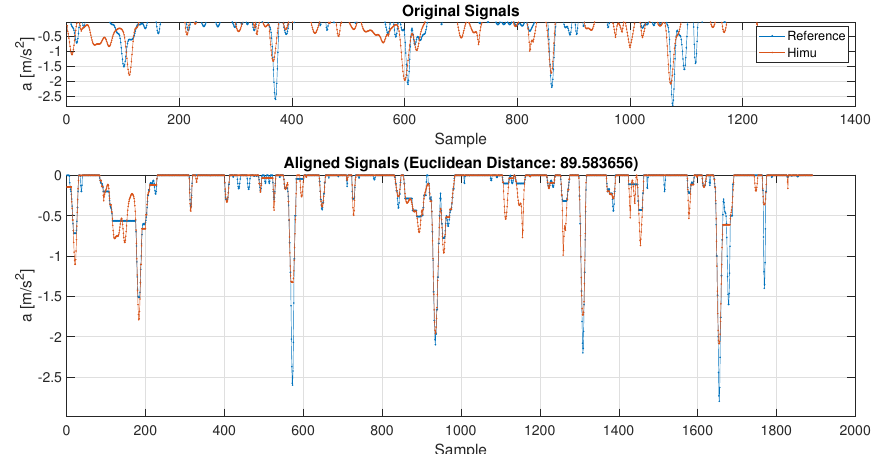
Figure 10. C1—DTW between reference and HIMU acceleration signals. Once the sensor acceleration signals are opportunely preprocessed (denoised, outlier removed, filtered and resampled), it is now possible to find the best configuration of the filtering parameters ( ω c ; n ) that minimize the Euclidean distance, evaluated with the DTW procedure, among the reference acceleration, a ref , and those ones detected by VBOX, GPS1 and HIMU sensors, respectively a VBOX , a GPS 1 and a HIMU . In particular, the interval of the cut off frequency ω c has been set between 0.1 Hz to 2 Hz with an increasing step equal to 0.05, whereas the filter order changes between 1 and 8 with an increasing step equal to 1. In the case of VBOX, Figure 11, the best configuration is achieved with an order equal to n = 7 and a cut-off frequency equal to ω c = 1.05 Hz. These parameters allow to reach = 74.8749. As it is possible to see in Figure 11b, a minimum distance equal to d a ref ; a VBOX the VBOX acceleration follows almost faithfully the reference signal: obviously the VBOX signal considers all the minimum decelerations inside the reference